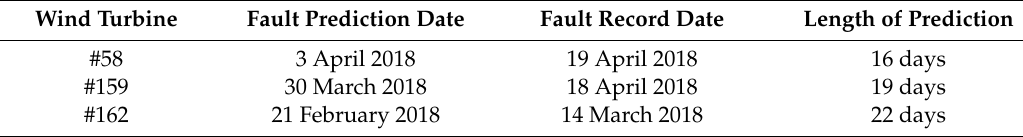
Table 8. Prediction results for the other three wind